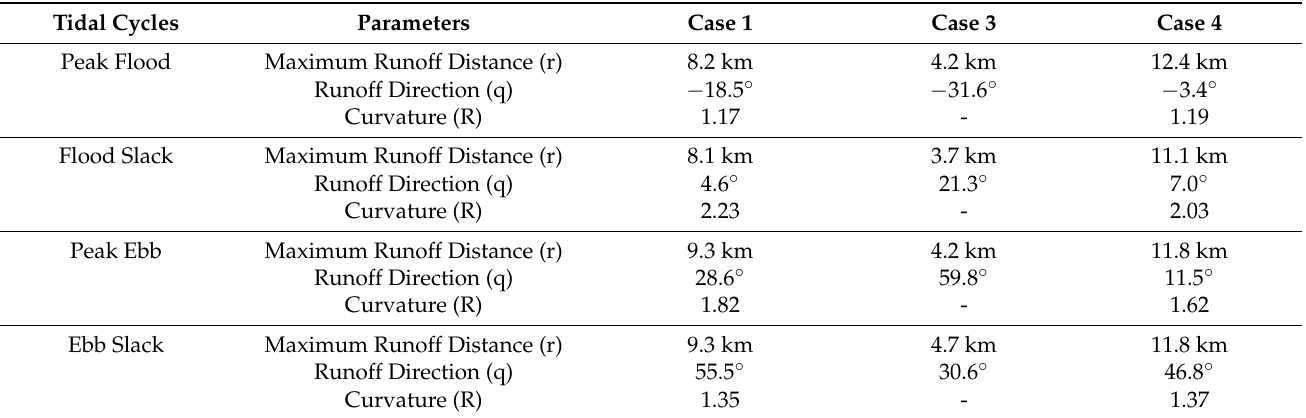
Table 4. Simulation results for maximum runoff distance (r), runoff direction (q), and curvature (R) in different cases. Note that parameters of Case 2 are not available because of its low sediment